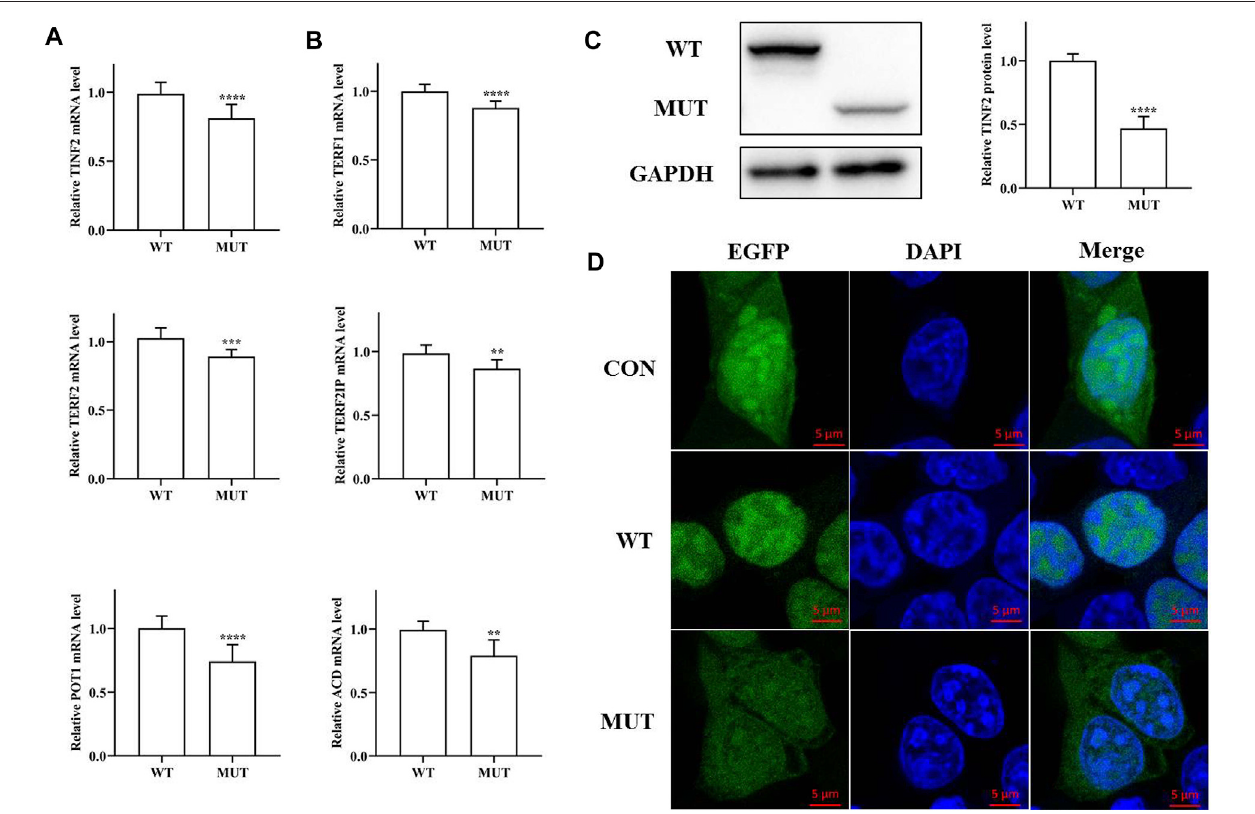
FIGURE5| Functionalstudyofthemutatedprotein. (A) mRNAexpressionlevelof TINF2 inHEK293T cells.Thereisasigni fi cantdifferenceinthemRNAlevelofthe wild-type and the mutant (*** p < 0.001). (B) mRNA expression level of other shelterin genes in HEK293T cells. The expression of other shelterin genes decreased to varying degrees. (C) . Protein expression level of TINF2 in HEK293T cells. The wild-type TINF2 is expressed at a higher level than the mutant (**** p < 0.0001). (D) . Subcellularlocalizationofwild-typeandmutant TINF2 inHEK293Tcells.Wild-type TINF2 islocalizedexclusivelytothenucleus.Mutant TINF2 distributethroughout the cell. Confocal images of EGFP (green), DAPI nuclear staining (blue), and merged signals.